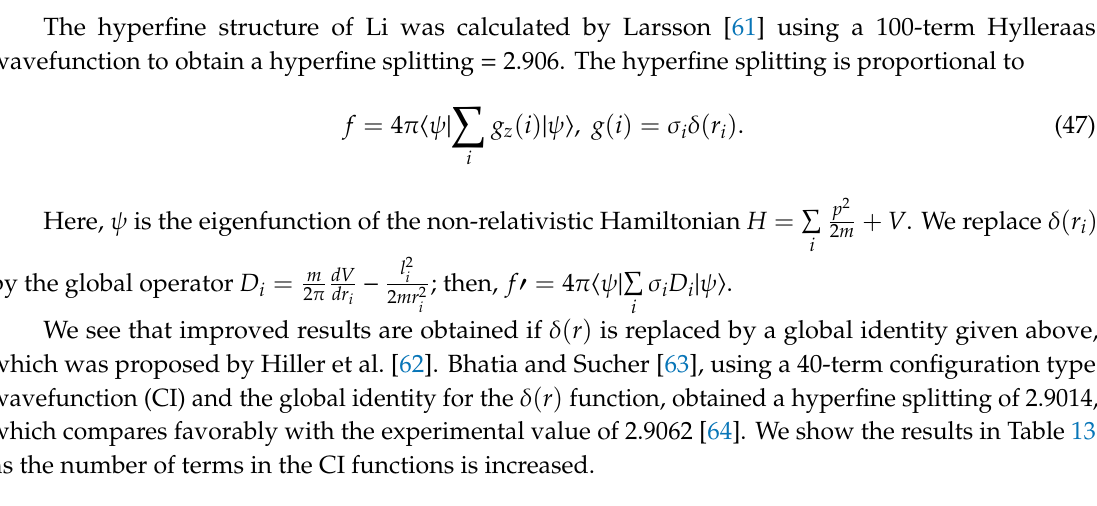
Table 13. Values of the energy and Fermi contact terms for various values of N in the calculation of the energy of a Li atom. N Energy